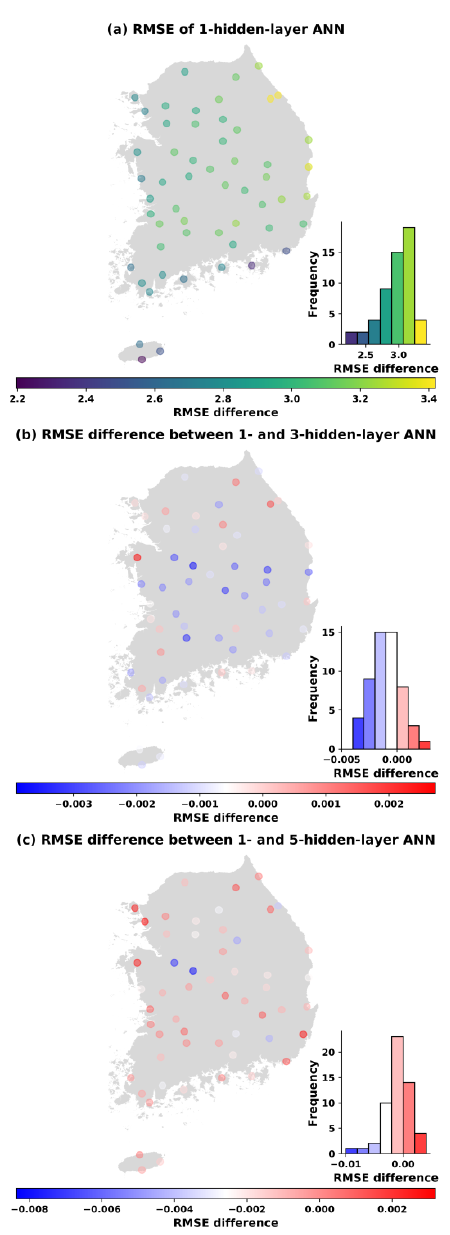
Figure 9. Panel ( a ) shows the RMSE of the test data of the 1-hidden layer model with 353 parameters; panel ( b ) shows the difference of the RMSE between the 1-hidden layer and the 3-hidden layer model (RMSE difference <0 indicates that the 1-hidden layer model performs better than the 3-hidden layer model and vice versa); and panel ( c ) shows the RMSE difference between the 1-hidden layer and the 5-hidden layer model (RMSE difference <0 indicates the that the 1-hidden layer model performs better, RMSE difference >0 shows the opposite).